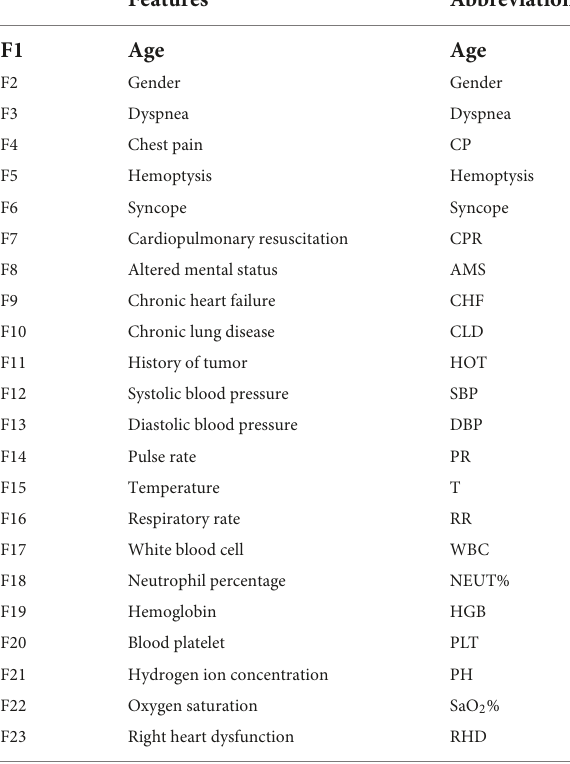
TABLE 1 Numbered list of the characteristics utilized in this study and their